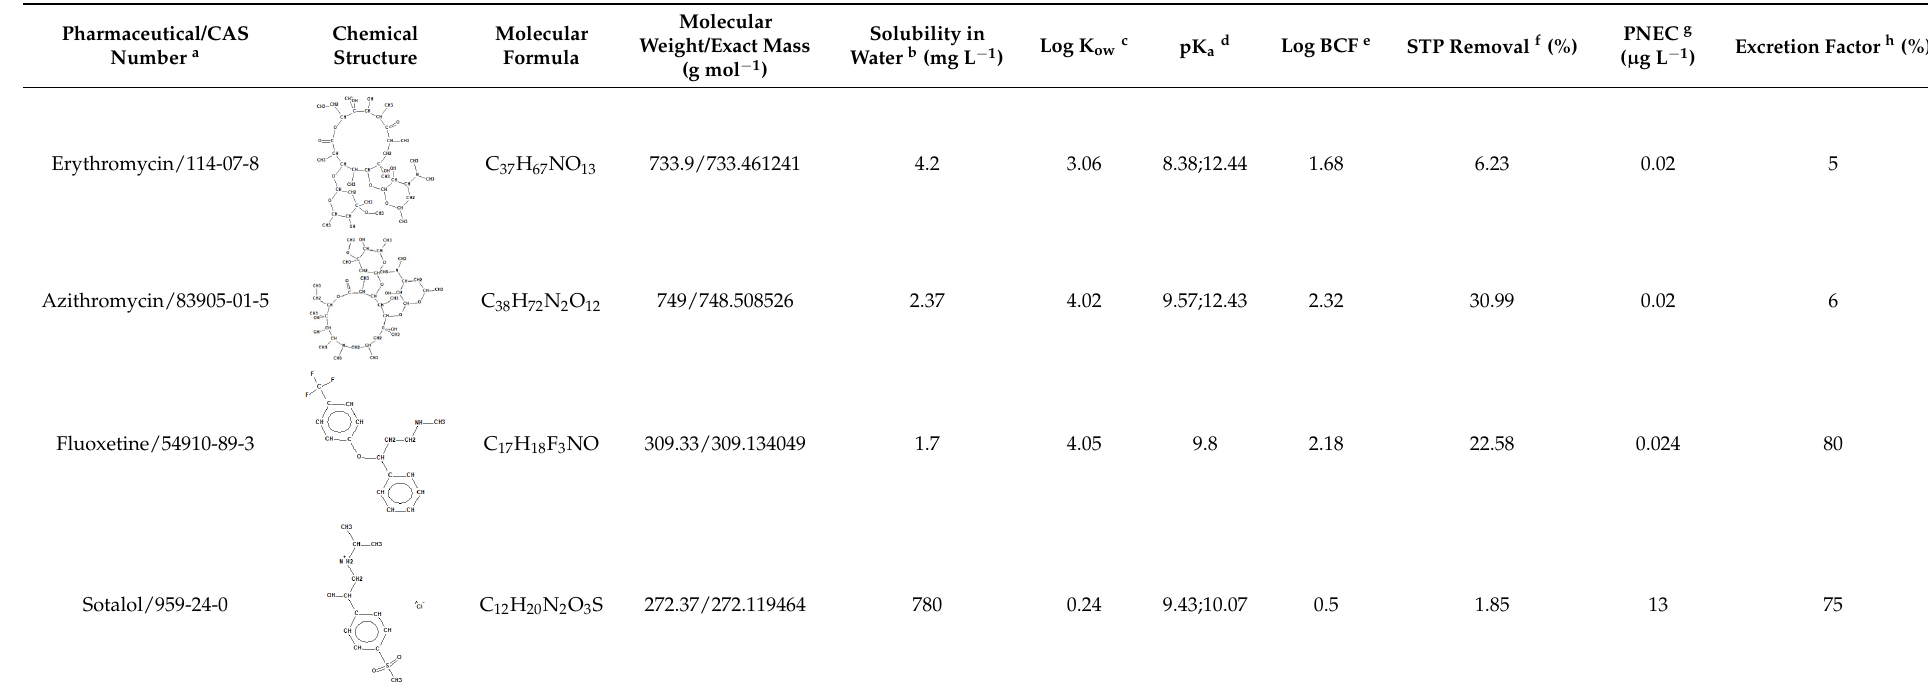
Table 1. Physical–chemical properties, toxicities, excretion factors and wastewater removal rates of the four pharmaceuticals under study.